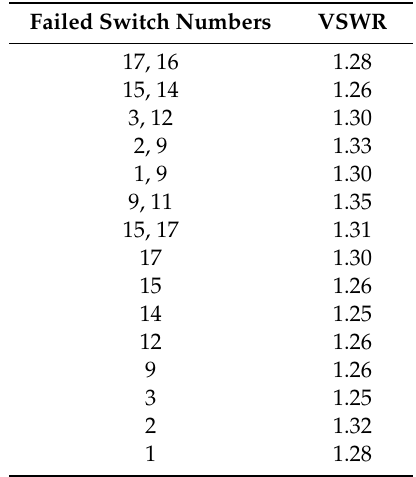
Table 1. Switch failure impact on the average VSWR value.